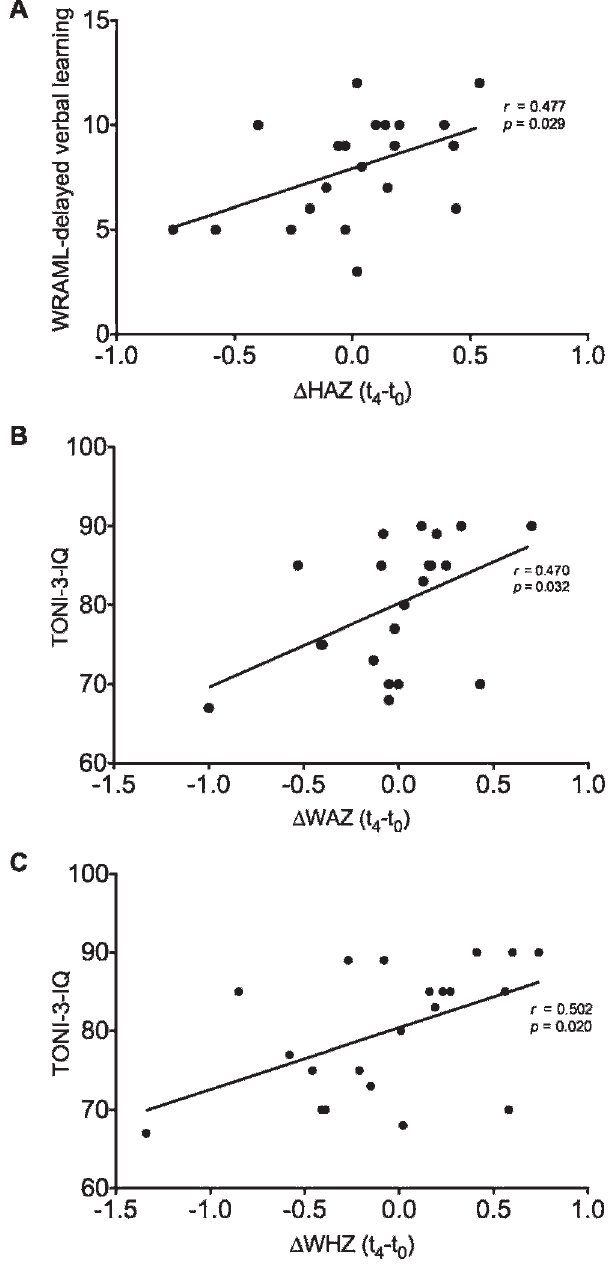
Figure 2 - Scatter plots indicating significant positive Pearson correlations between the changes in anthropometric